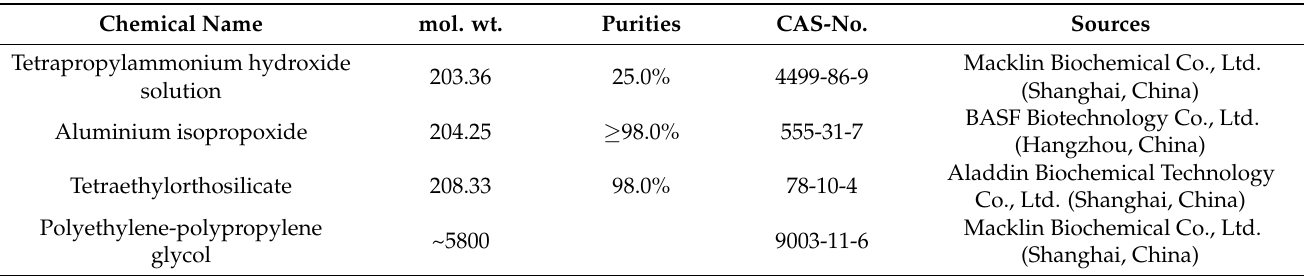
Table 1. Chemicals used in the